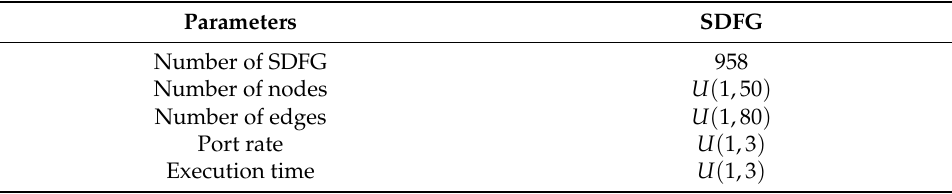
Figure 6. SDFG random generator process. Table 2. Evaluation settings for SDFG random